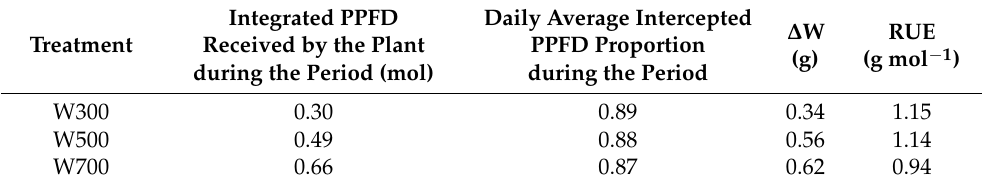
Table 2. Effects of PPFD on light interception, biomass production, and radiation-use efficiency (RUE) of ‘Micro-Tom’ during the 6-day experimental period in Experiment 1. ∆ W (g) is the accumulated total dry mass during the experimental period. RUE is defined as the ratio of the accumulated total dry mass to integrated PPFD received by the plant during the period. W300, W500, and W700 denote 300, 500, and 700 µ mol m − 2 s − 1 PPFD, respectively. Each value of ∆ W represents the average of four plants.